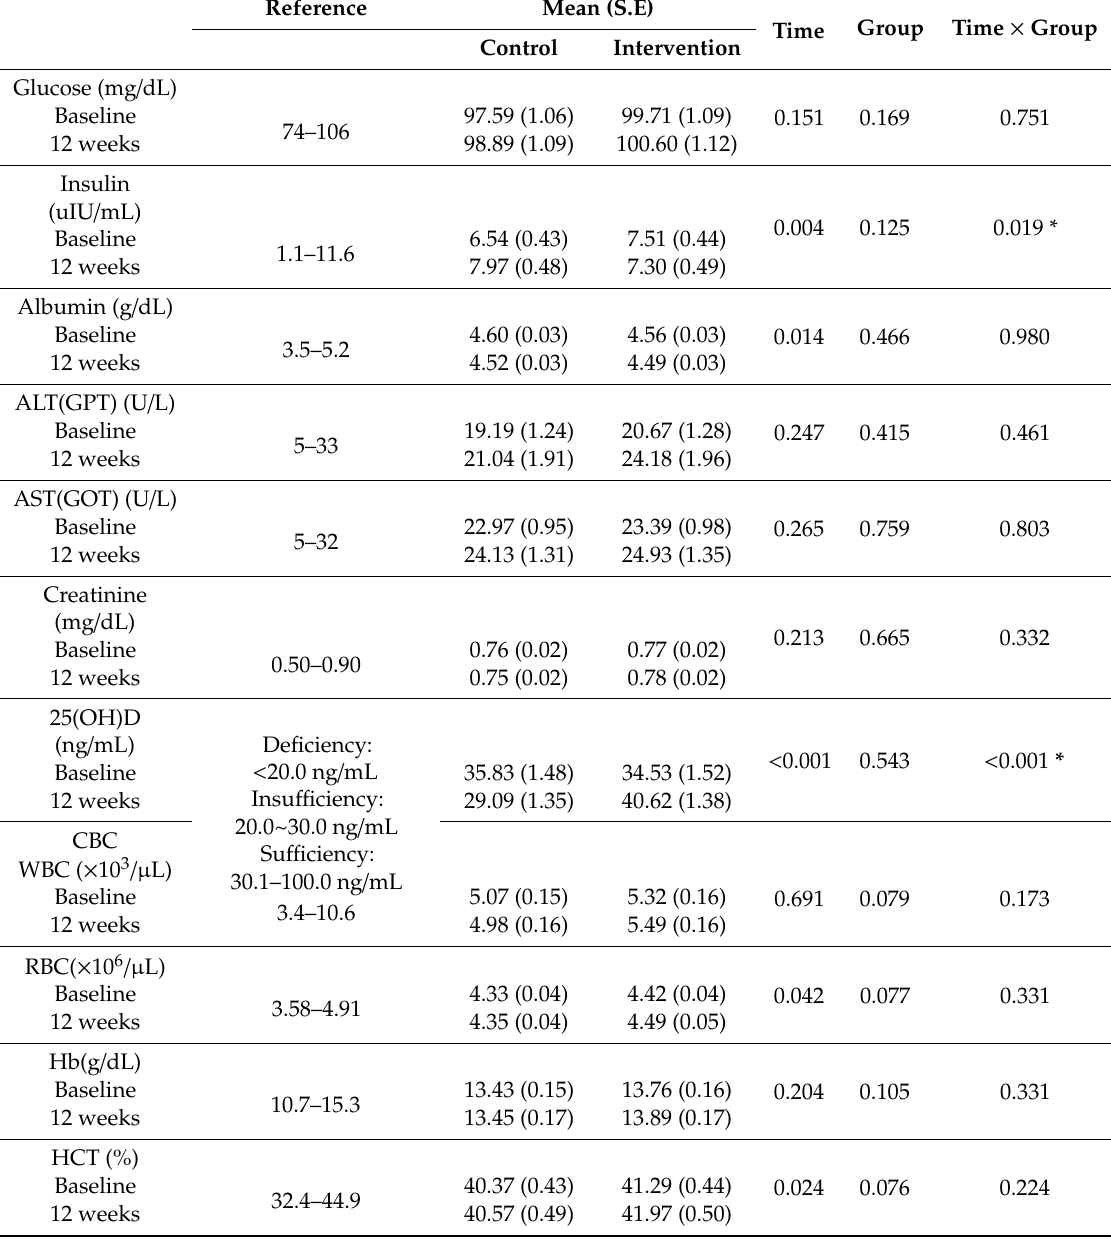
Table 4. Blood measurement changes during the 12-week study